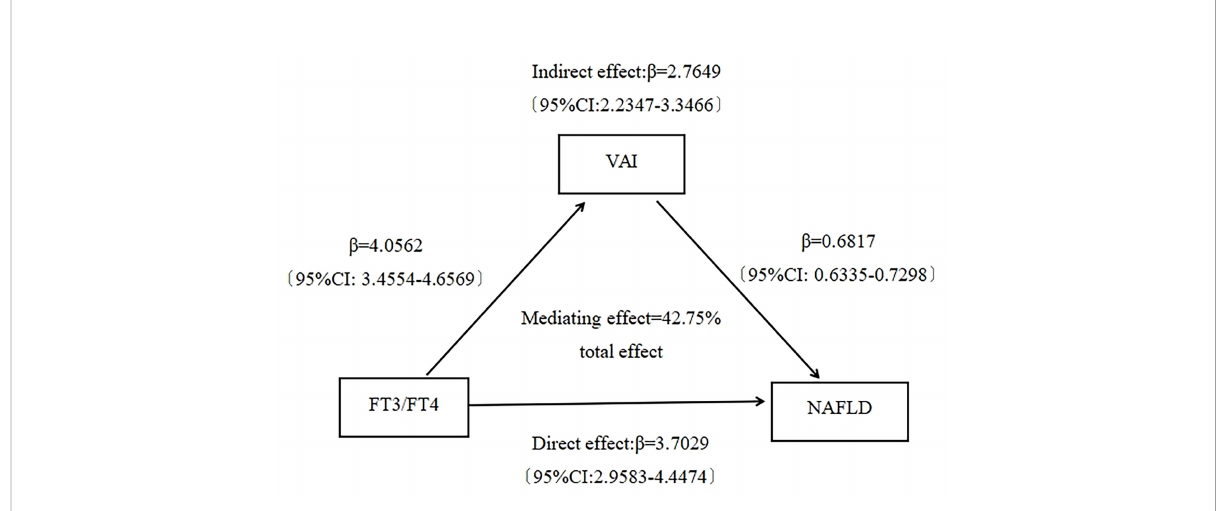
FIGURE 2 Mediating effect analysis of visceral adiposity index on the association between FT3/FT4 ratio and NAFLD.